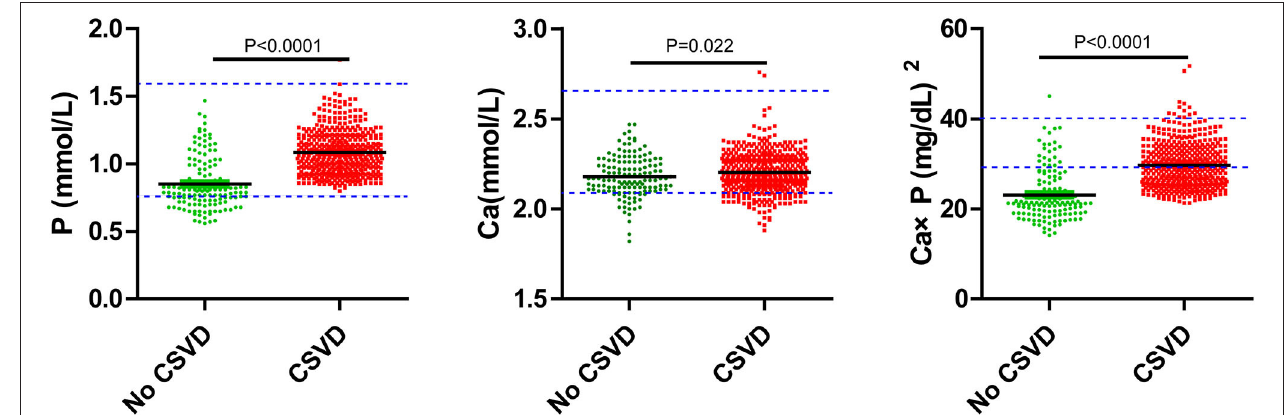
FIGURE 5 | Serum P, Ca, Ca × P, and concentration of no CSVD and CSVD. Blue dotted lines are the upper and lower limits of normal values.